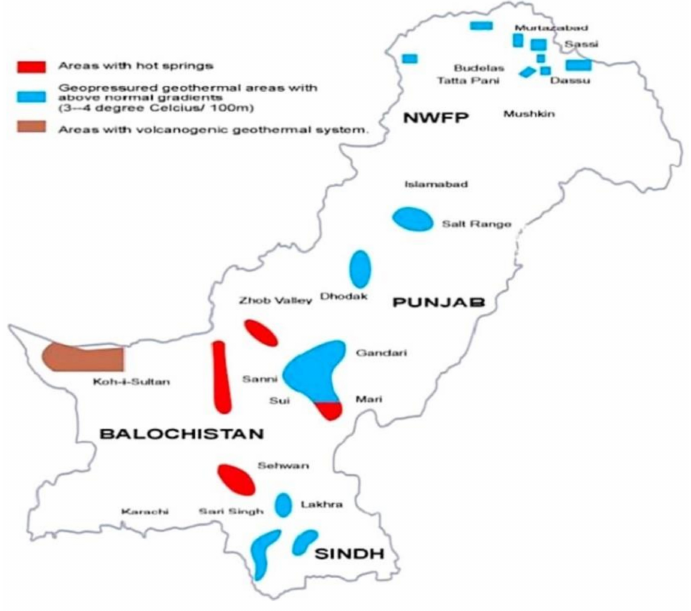
Figure 5. Geothermal resource map of Pakistan